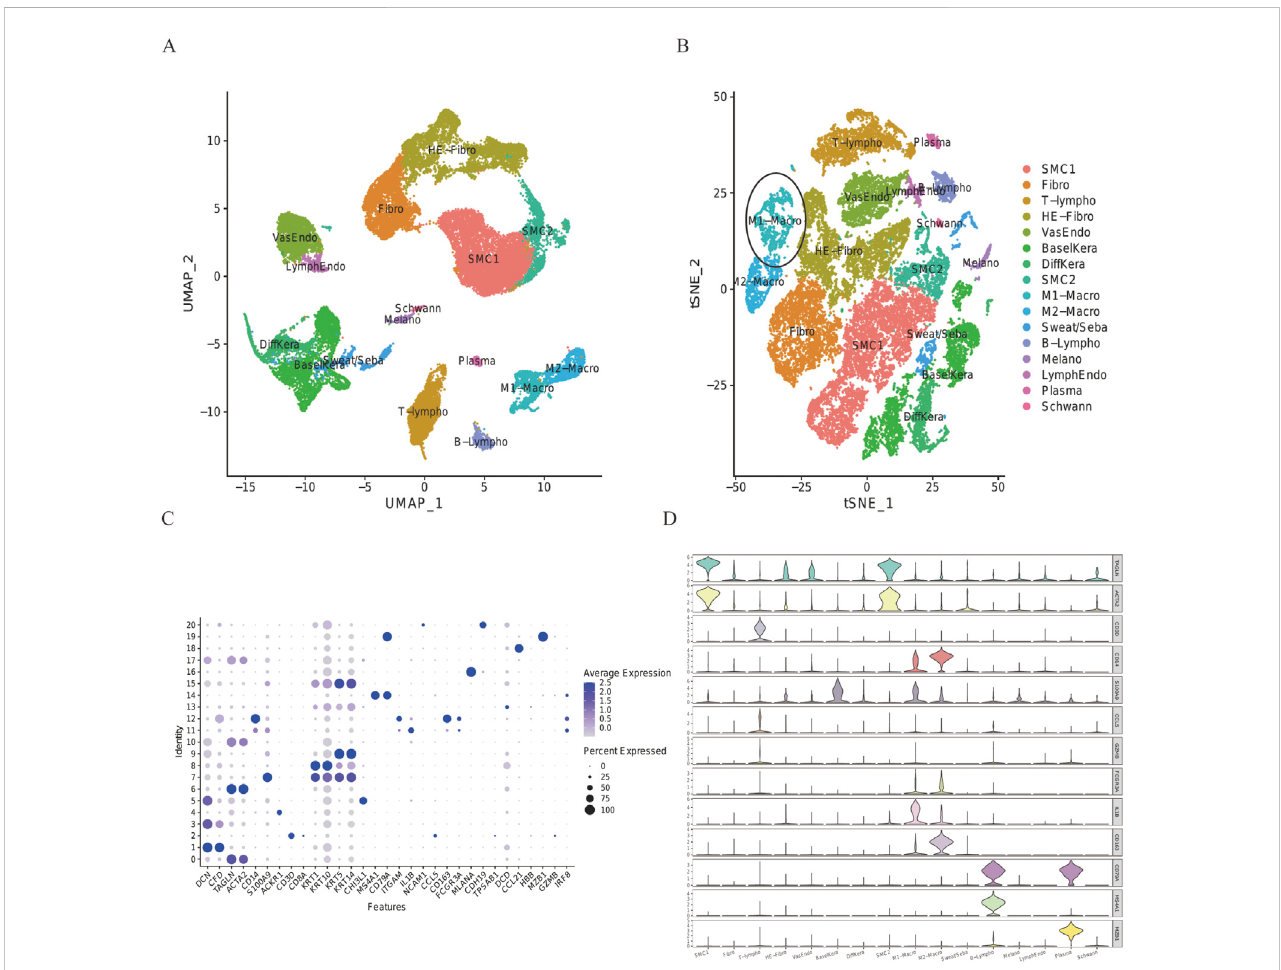
FIGURE 2 Expression of every cluster ’ s marker genes. (A) 32,574 cells from all scRNA were projected using tSNE. Different colors indicate different cell types. (B) DFU group ’ s tSNE projection. Ellipsoidal labeling was used to identify M1-Macro cells, and the number of these cells dropped in the DFU group. (C) Cell-type marker gene dot plot. The genes for cell-speci fi c markers were chosen based on earlier research. The size and color of the dots indicate the average percentageofcellsthatexpressthechosengene,respectively. (D) Violinplotusesdensitycurvestoshowhowthecell-typemarkergenesaredistributed within every cluster. Every violin plot ’ s breadth re fl ects the proportion of cells with the appropriate level of gene